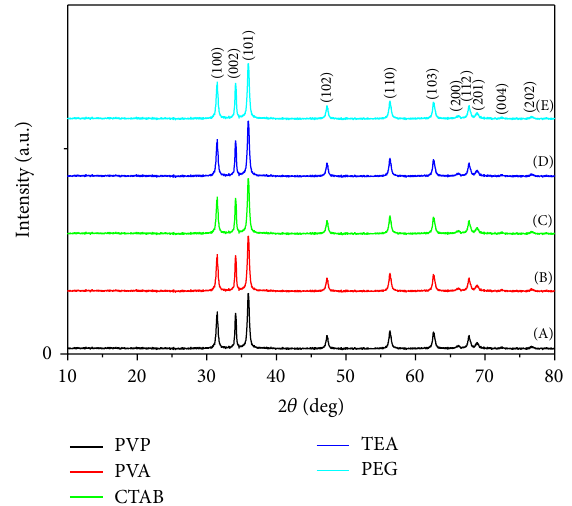
Figure 9: XRD patterns for ZnO nanopowders via hydrothermal technique with different surfactant agents: (A) PVP, (B) PVA, (C) CTAB, (D) TEA, and (E)